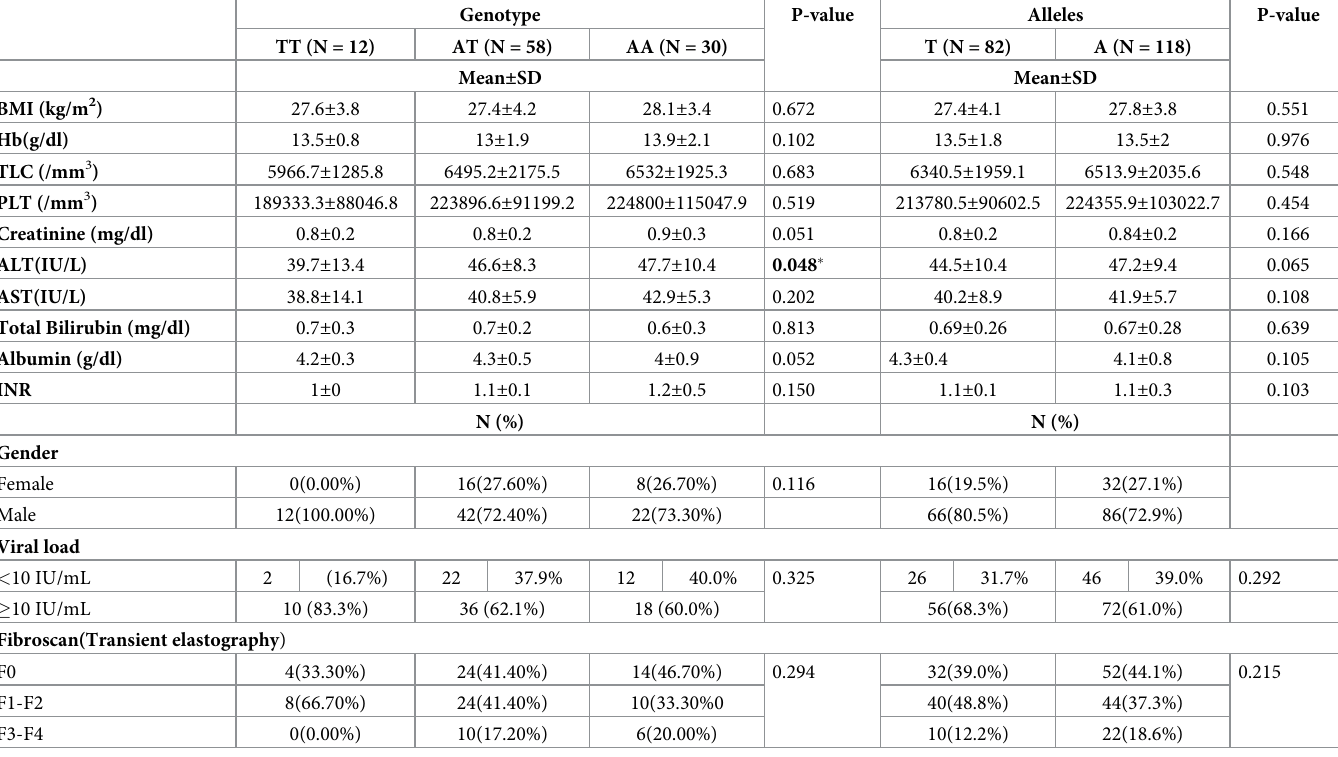
Table 3. The miR-155 T/A polymorphism (rs767649) to the characteristics of cases with chronic hepatitis B viral infection. Genotype P-value Alleles